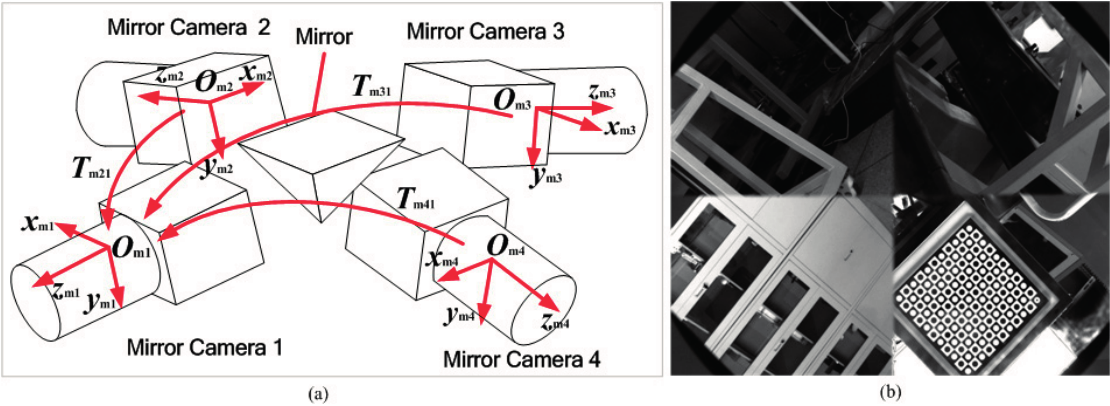
Figure 3. ( a ) Schematic image of the wide-field camera; ( b ) Image captured by the wide-field